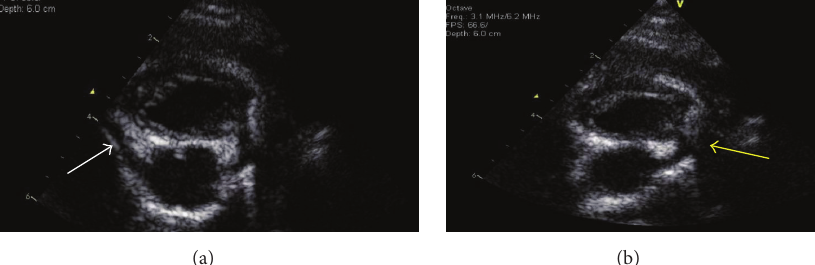
Figure 7: Postsurgical transthoracic echocardiographic images of the right and left coronary arteries. (a) 2D and color Doppler transthoracic image of the persistently dilated right coronary artery (white arrow). (b) 2D and color Doppler transthoracic image of the persistently dilated left main coronary artery (yellow